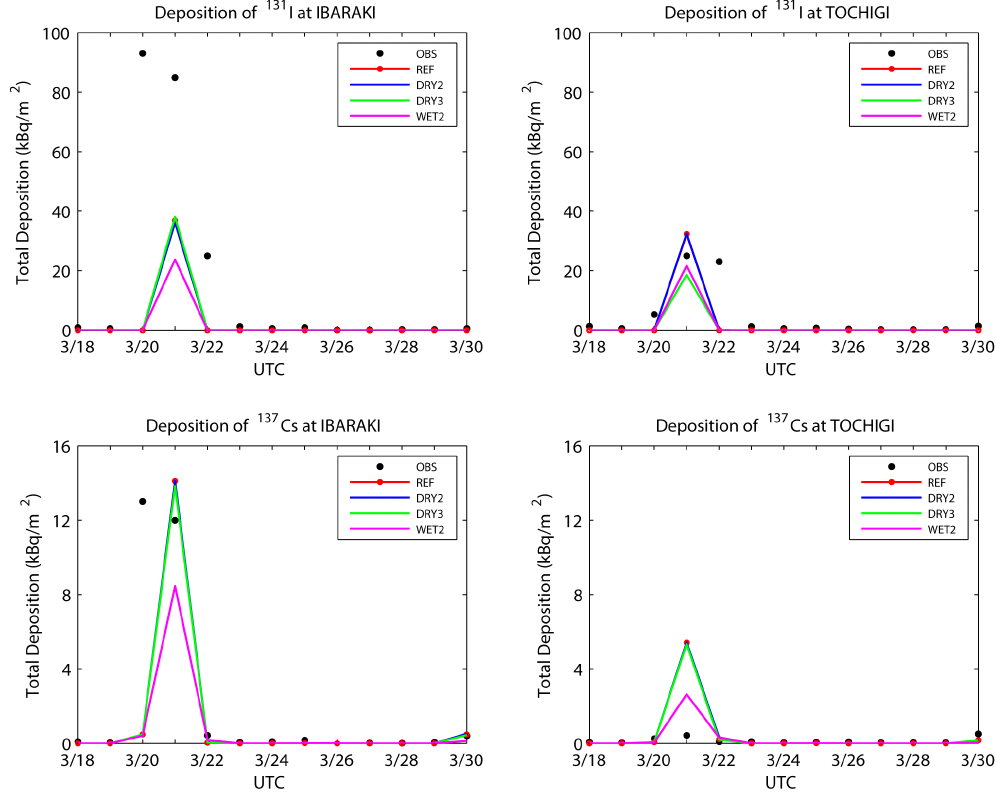
Figure 11. Daily total depositions in station IBARAKI and TOCHIGI with different dry and wet parameterizations.